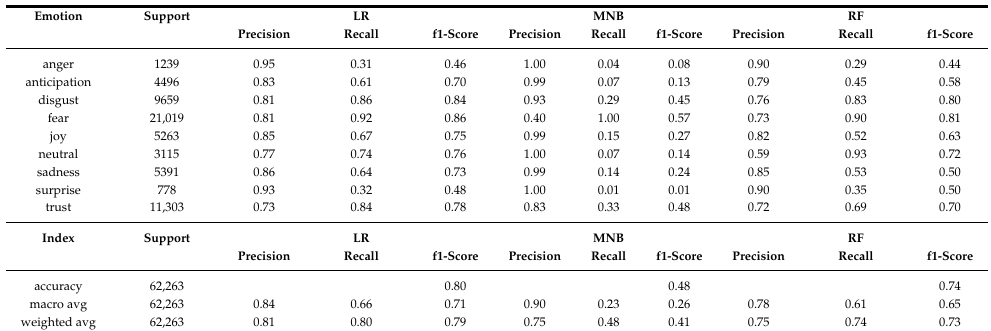
Figure 14. Splitting tweets data. Table 3. Performance of logistic regression (LR), multinomial Bayes model (MNB), and random forest (RF) with respect to emotion labels and